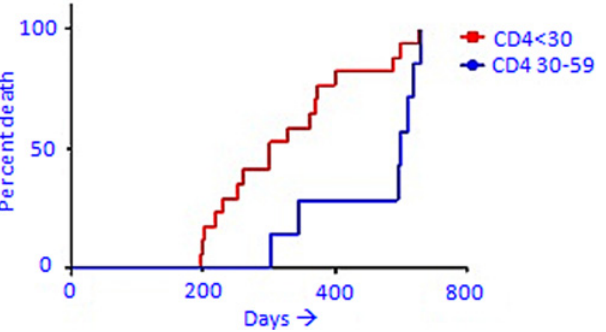
Fig 1. Comparison of death rates between subjects with CMV end organ diseases (EODs) with CD4 counts < 30 and 30 – 59 (following the assumptions of the Cox proportional hazard model and after adjustments for age and